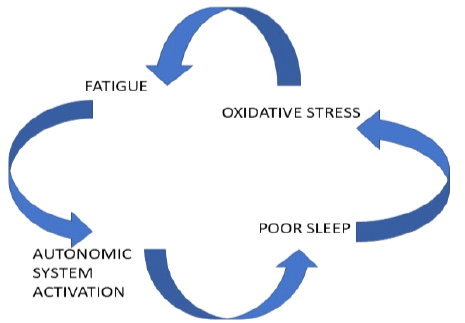
Figure 2. Interactions among the triggering factors in Esports